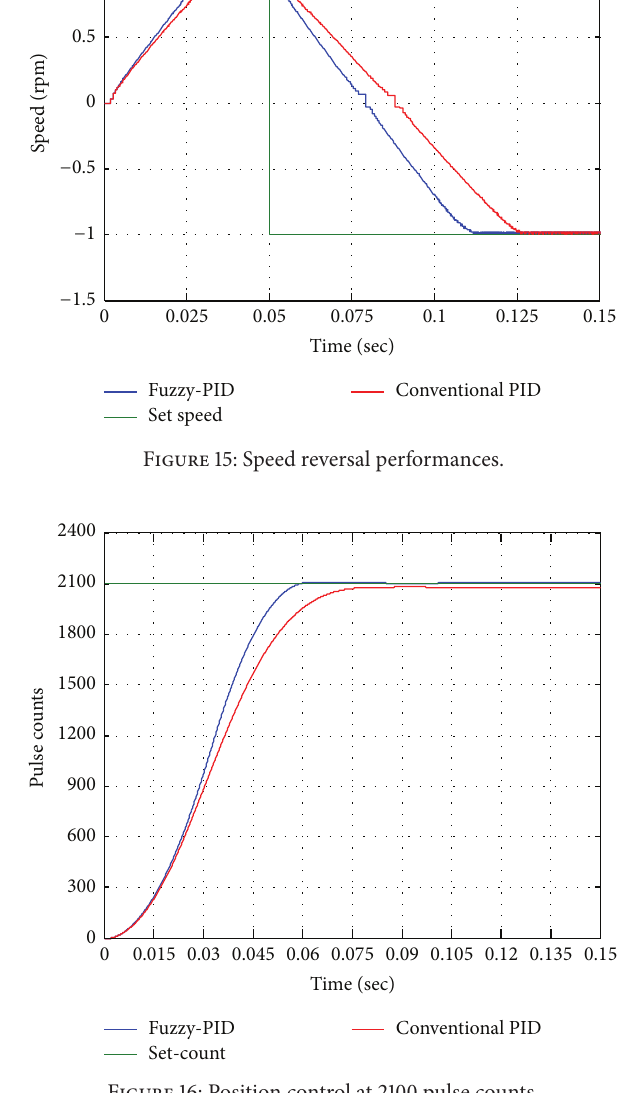
Figure 16: Position control at 2100 pulse counts.